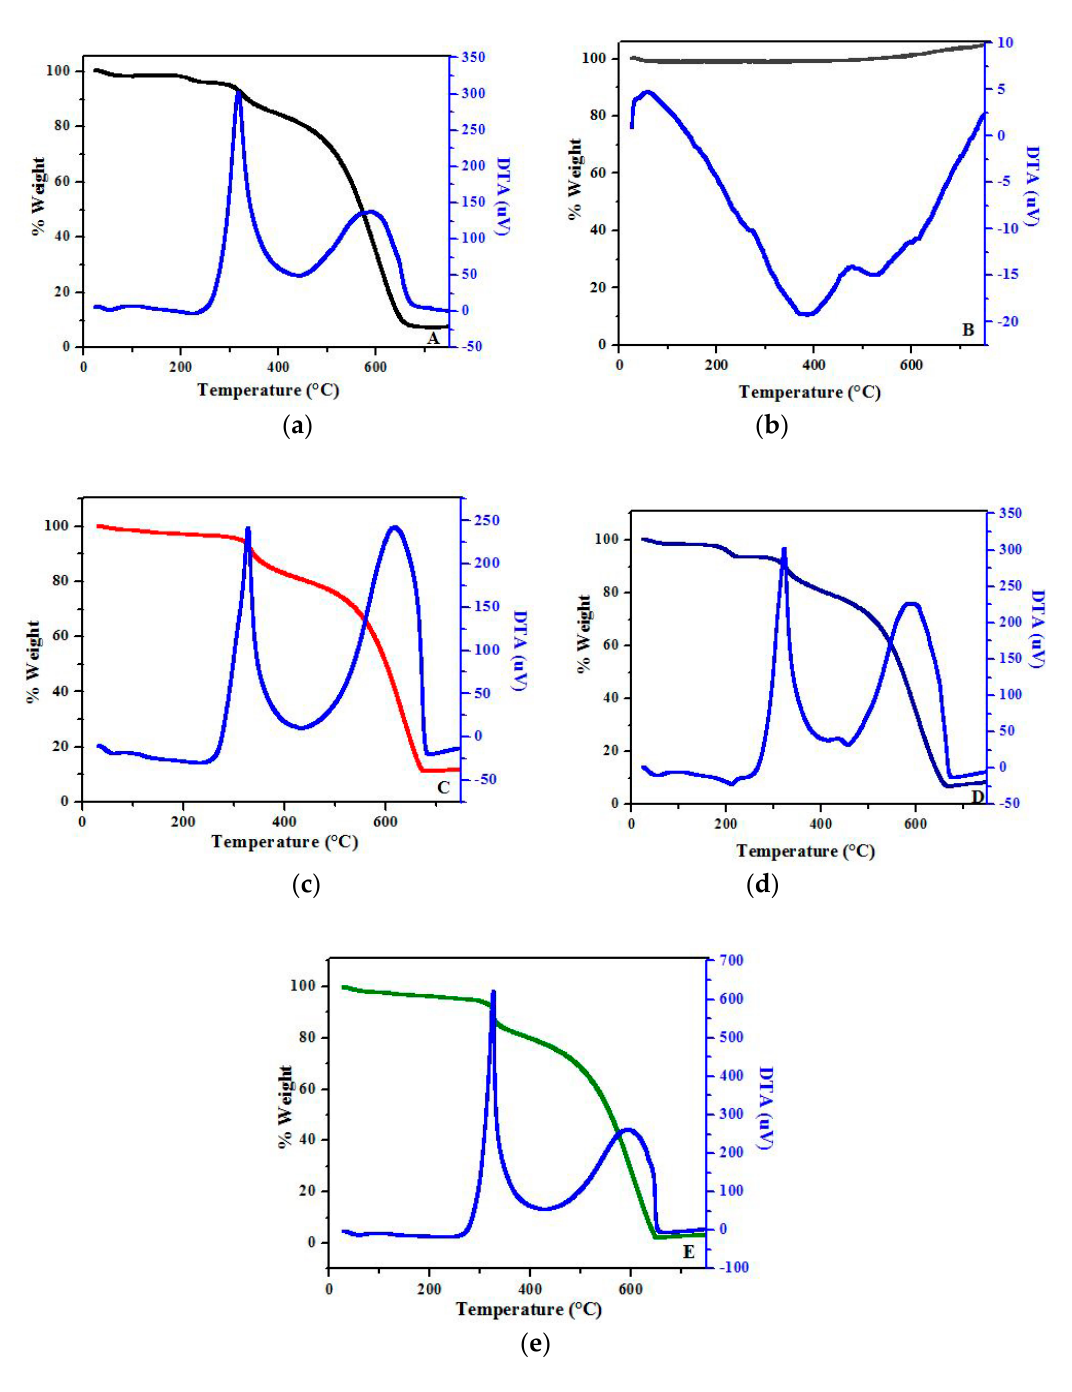
Figure 4. TGA and DTA curves of ( a ) PAN, ( b ) FS, ( c ) PAN-FS0.1, ( d ) PAN-FS0.5 and ( e ) PAN-FS1.